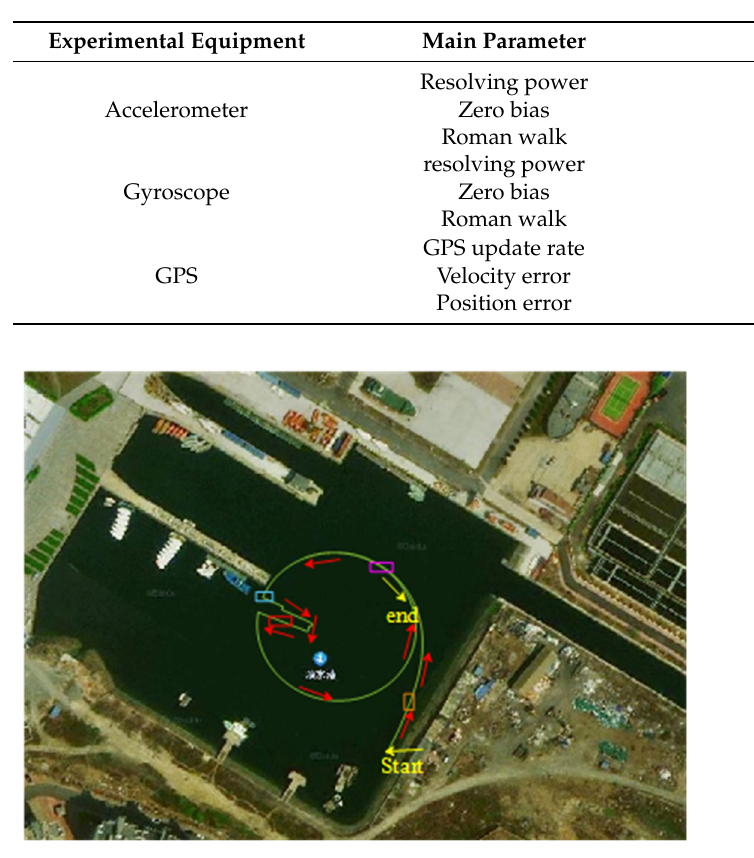
Figure 7. Ship track chart. Table 3. Setting of GPS interruption during